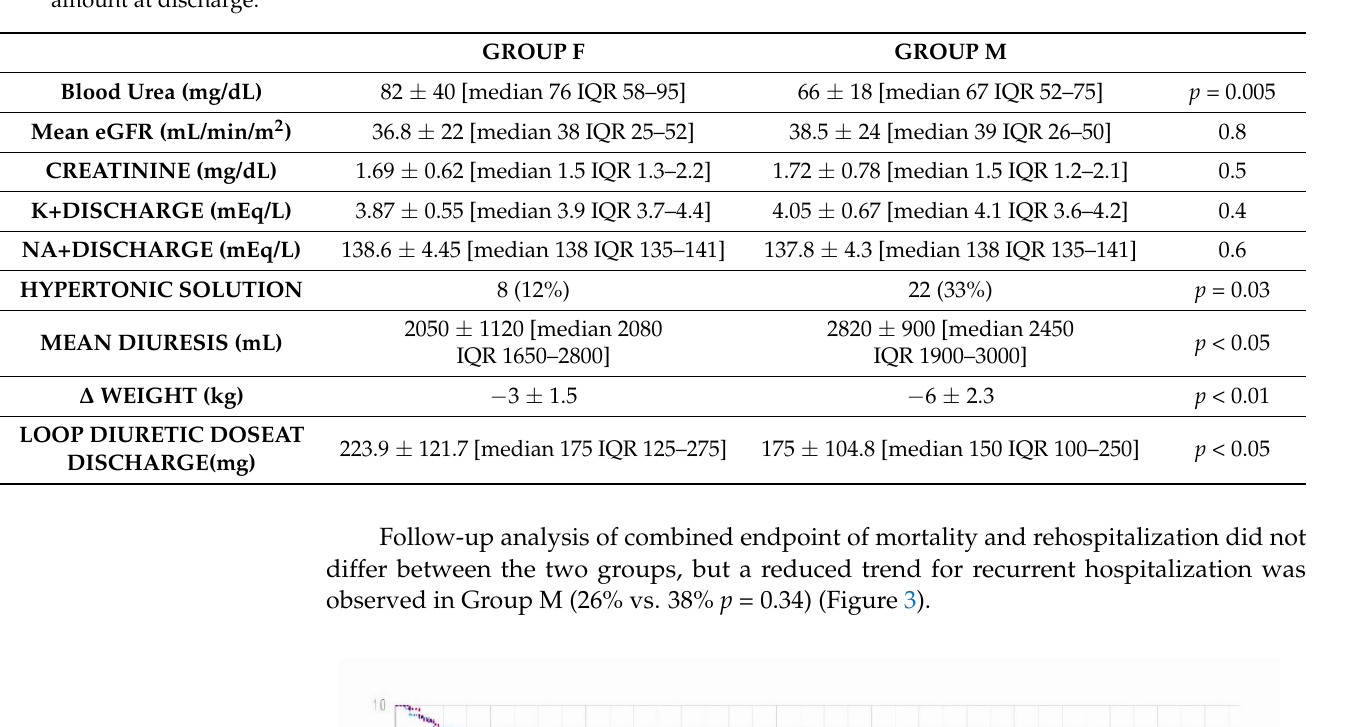
Table 3. Effects of metolazone plus furosemide (Group M) vs. furosemide alone (Group F) admin- istration on renal function electrolyte balance and saline solution. Metolazone addition showed sig- nificant weight loss and less oral loop diuretic amount at discharge.